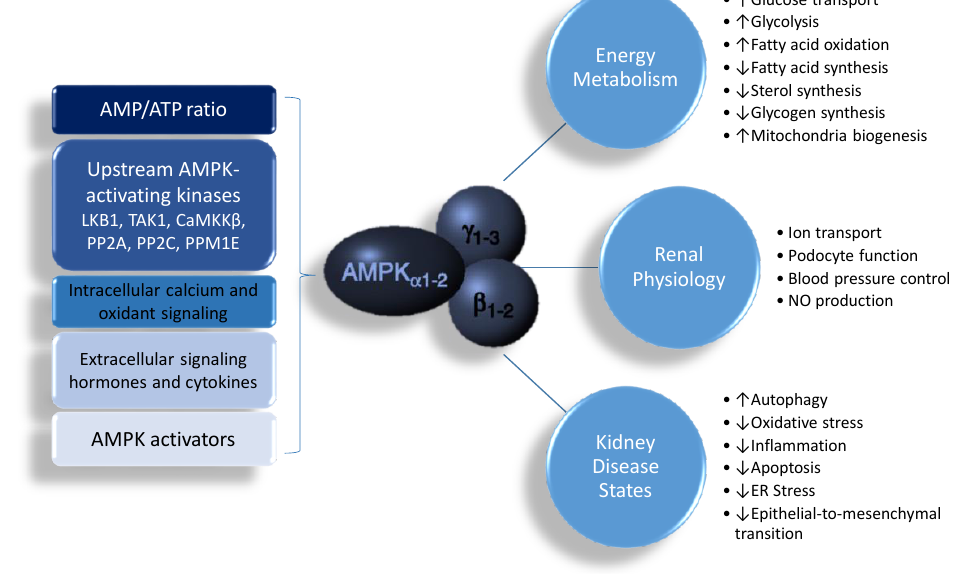
Figure 1. Schematic representation of AMP-activated protein kinase (AMPK) actions and its biochemical functions in the kidney. ↑ = increased. ↓ = decreased.